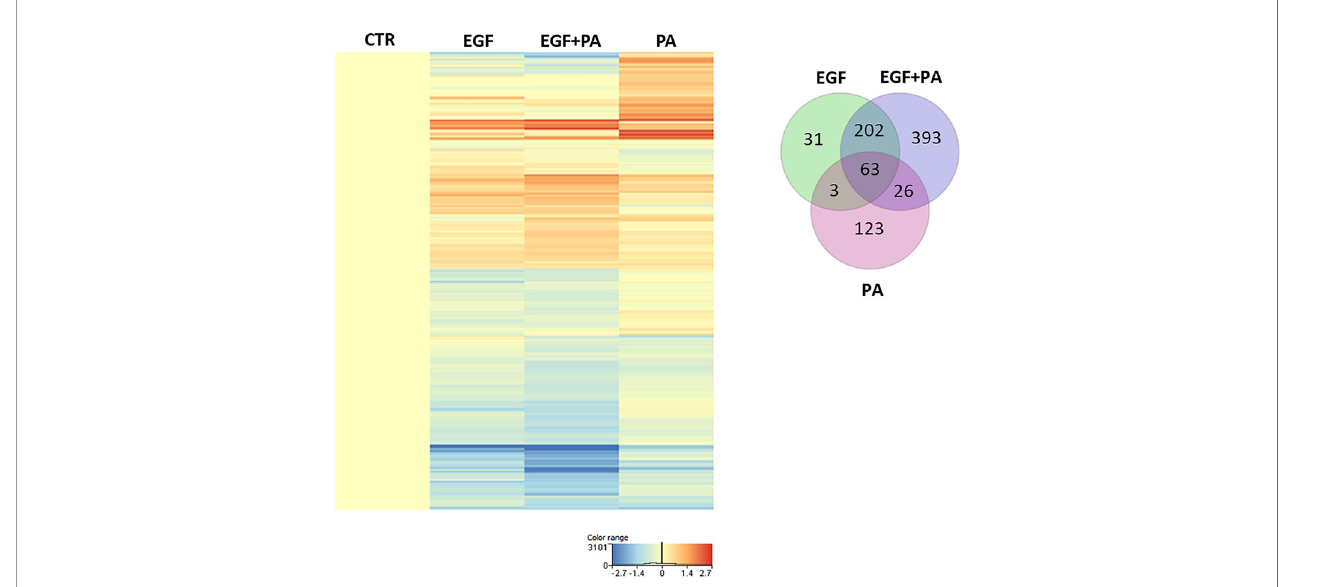
FIGURE 3 | Gene expression pro fi le of EGF-treated, PA-treated and EGF+PA-co-treated sebocytes. Differentially expressed genes shown as a heat map in SZ95 sebocytes treated with PA for 24 hours in the absence (PA) or presence of EGF (EGF+PA), and in SZ95 sebocytes cultured in the presence of EGF (EGF) when compared to cells cultured in the absence of EGF (CTR) as observed by our RNA-seq analysis. Differentially expressed genes were normalized to control and results are expressed as average mean of three samples from subcultures of SZ95 sebocytes. Color intensities re fl ect the ratios of signal intensities as shown. Venn diagram visualizes the number of genes which are signi fi cantly regulated between treatment conditions (EGF (green), EGF+PA (purple) and PA (pink) treated SZ95 sebocytes) 24 hours after PA treatment when compared to SZ95 sebocytes cultured in the absence of EGF (CTR) as observed by our RNA-seq